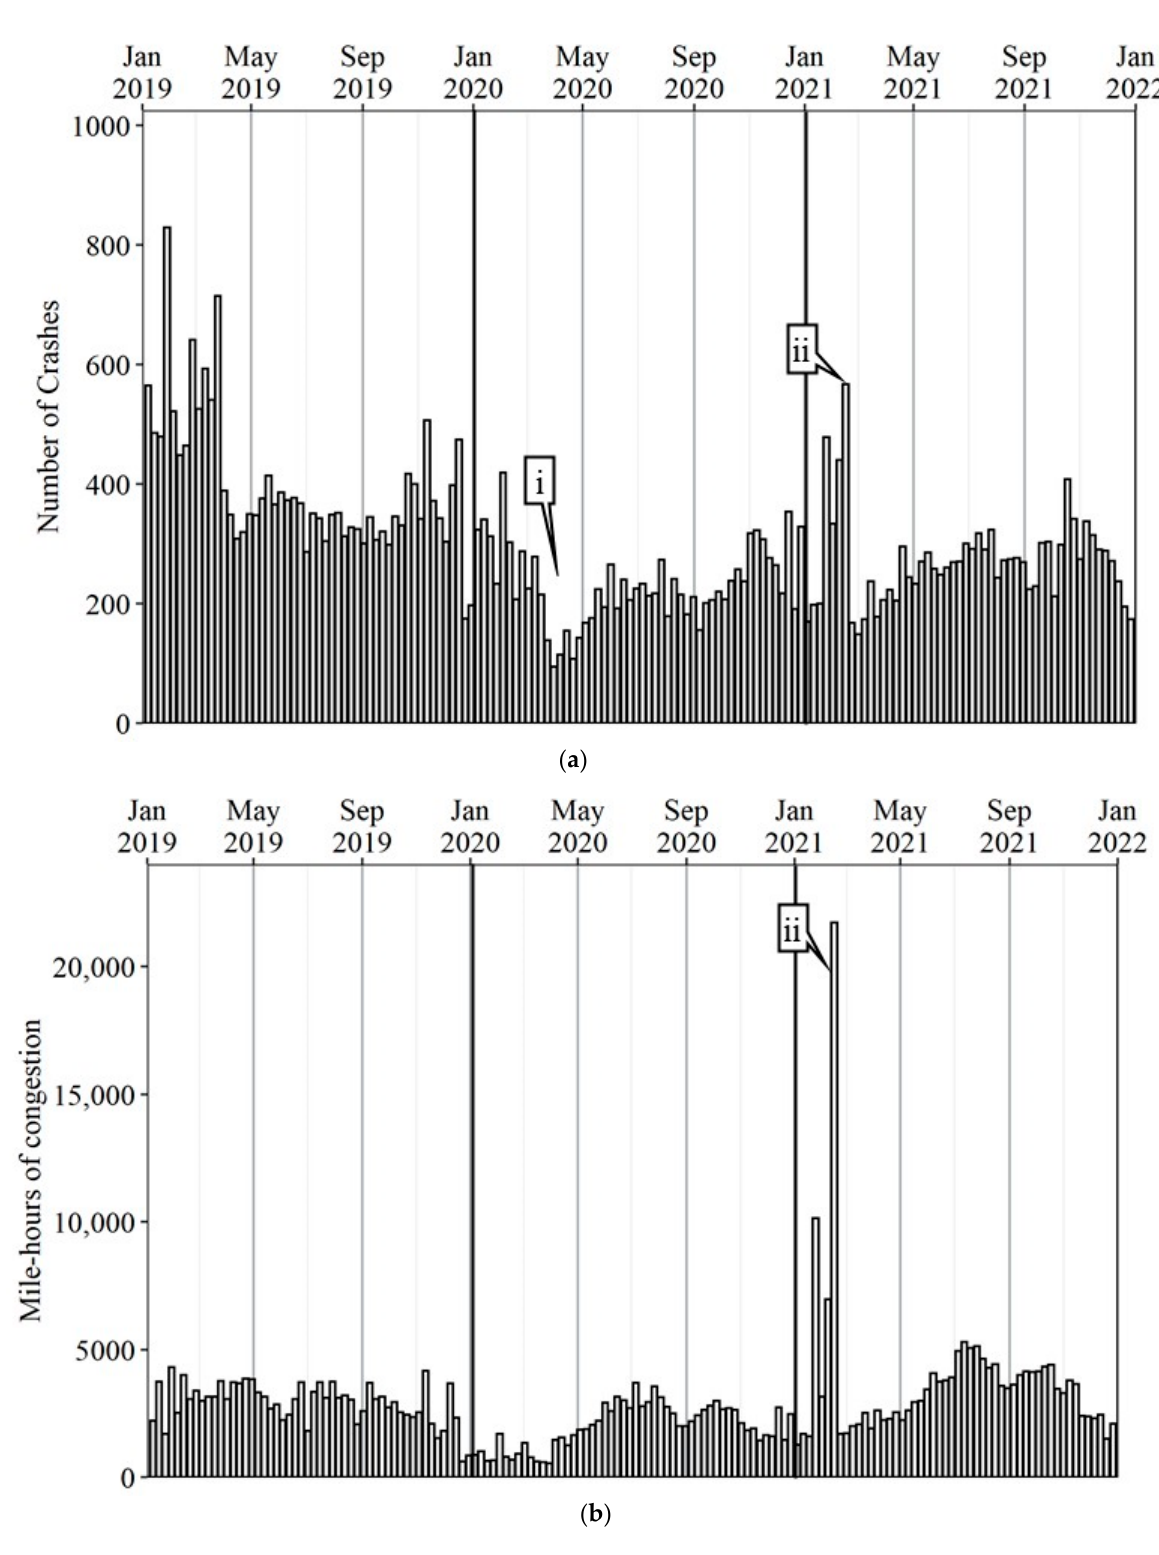
Figure 2. Performance metrics over three years across all Indiana interstates. ( a ) Weekly number of crash incidents; ( b ) Weekly mile–hours of congestion (<45 mph). crash incidents; ( b ) Weekly mile–hours of congestion (<45